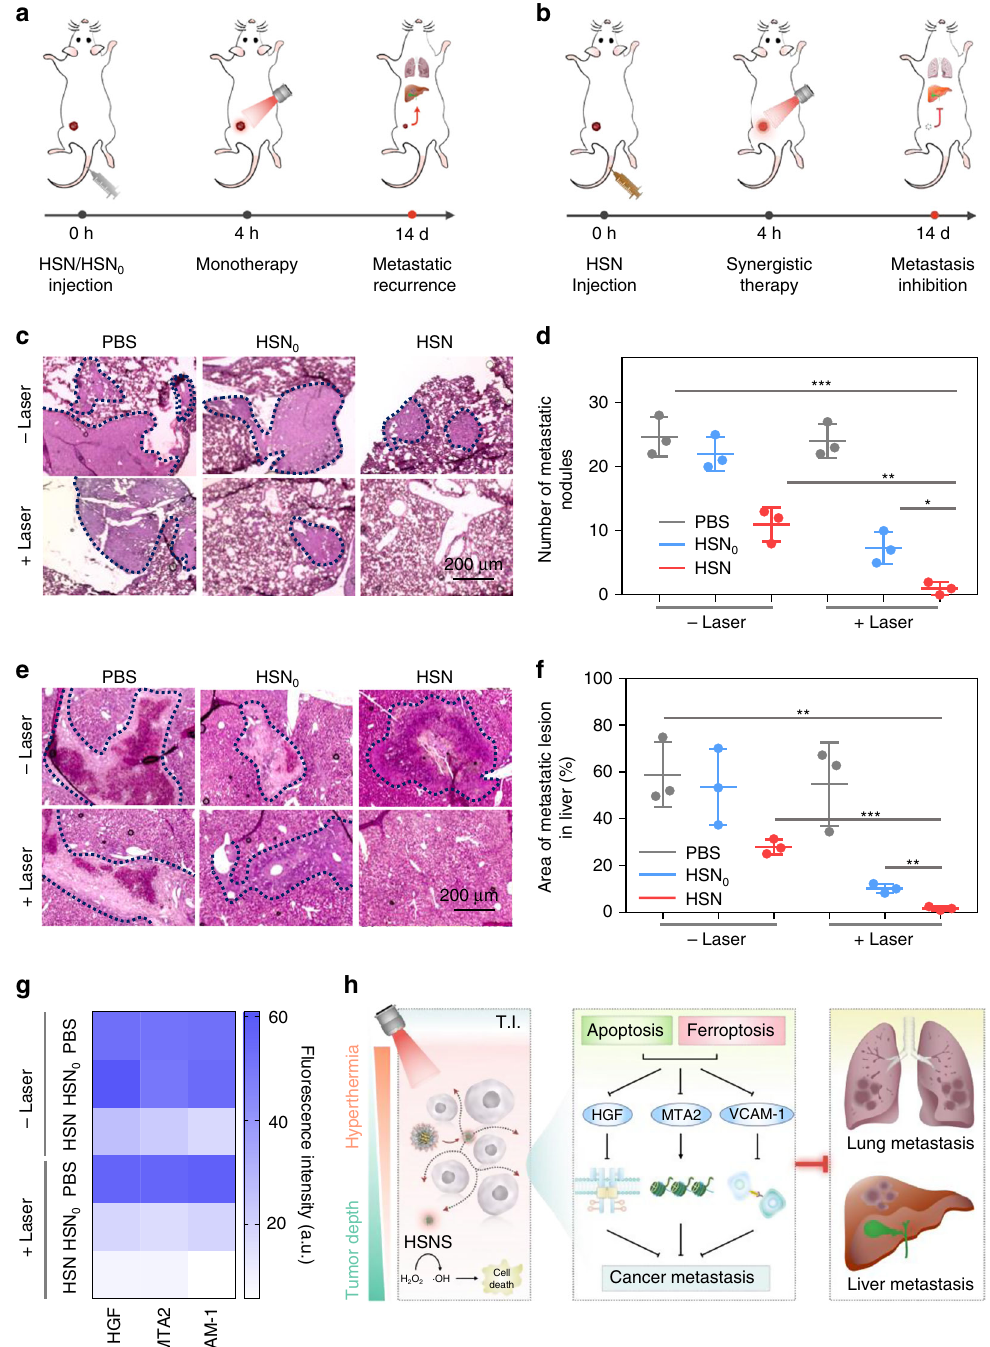
Fig. 5 Cancer metastasis inhibition by HSN-mediated NIR-II photothermal ferrotherapy. a , b Schematic illustration of treatment schedule of monotherapies and photothermal ferrotherapy. H&E images of lung ( c ) and liver ( e ) metastasis of living mice after various treatments. Metastatic area was indicated by dotted lines . d Number of metastasis nodules per lung in mice after various treatments. f Area of metastatic lesions in liver per mice after various treatments. P -values were calculated by Student ’ s two-sided t -test. * P < 0.05, ** P < 0.01, *** P < 0.001 ( n = 3). g Mechanistic study and h illustration of molecular mechanism of metastasis inhibition by HSN-mediated NIR-II photothermal ferrotherapy. Quanti fi cation of expression levels of HGF, MTA2, and VCAM-1 in tumor tissues (at 9 mm, Supplementary Fig. 16) in living mice. T.I. tumor interstitium. Error bars indicated standard deviations of three independent